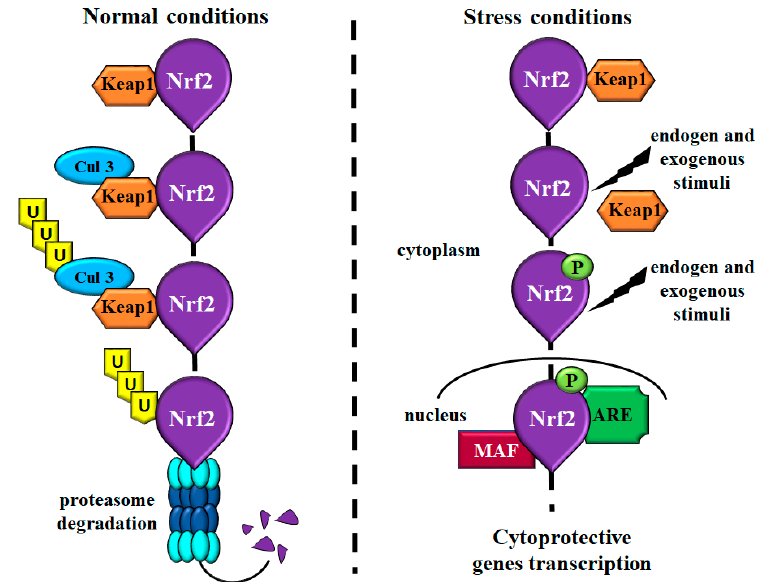
Figure 1. Schematic representation showing the main Nrf2 molecular mechanisms. Under normal condition, Nrf2 binds its inhibitor Keap1 that mediates the interaction with Cul3 leading to Nrf2 ubiquitination and proteasome degradation. These events provide a regulated modulation of Nrf2 levels in the cells. Under stress conditions and in response to different insults, Keap1 is inactivated, and Nrf2 is phosphorylated and translocated into the nucleus. In the nucleus, Nrf2 binds MAF proteins and, consequently, ARE sequences inducing the transcription of cytoprotective genes. Abbreviations: Cul3 = Cul3-based E3-ubiquitin ligase; Keap1 = Kelch-like ECH-associated protein 1; Nrf2 = nuclear factor-erythroid 2-related factor; MAF = musculoaponeurotic fibrosarcoma proteins; ARE = antioxidant responsive element; P =